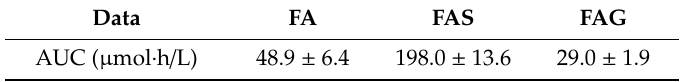
Table 3. The AUCs (expressed as µ mol · h / L) of FA, and FA conjugates after FA administration.